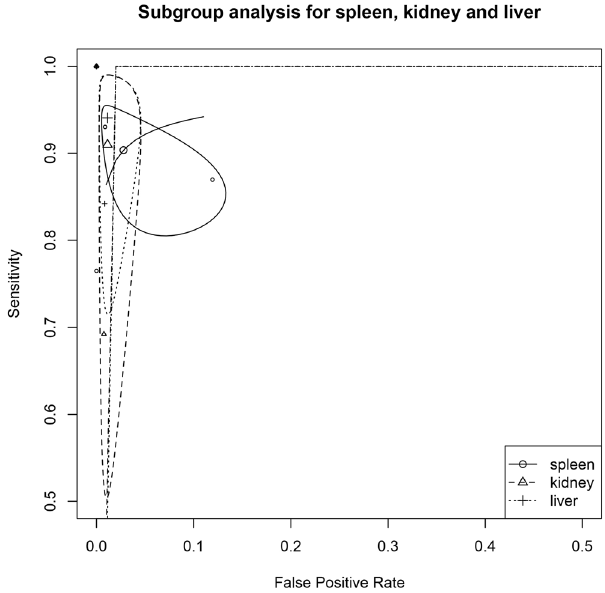
Figure 4. Summary receiver operating characteristic (SROC) curve for subgroup analysis restricting to different solid organs liver, kidney and